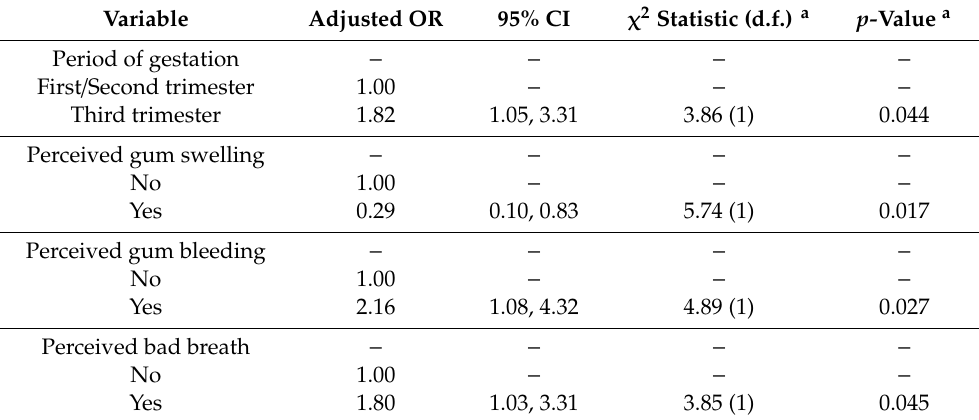
Table 5. Factors associated with periodontal pockets using multiple logistic